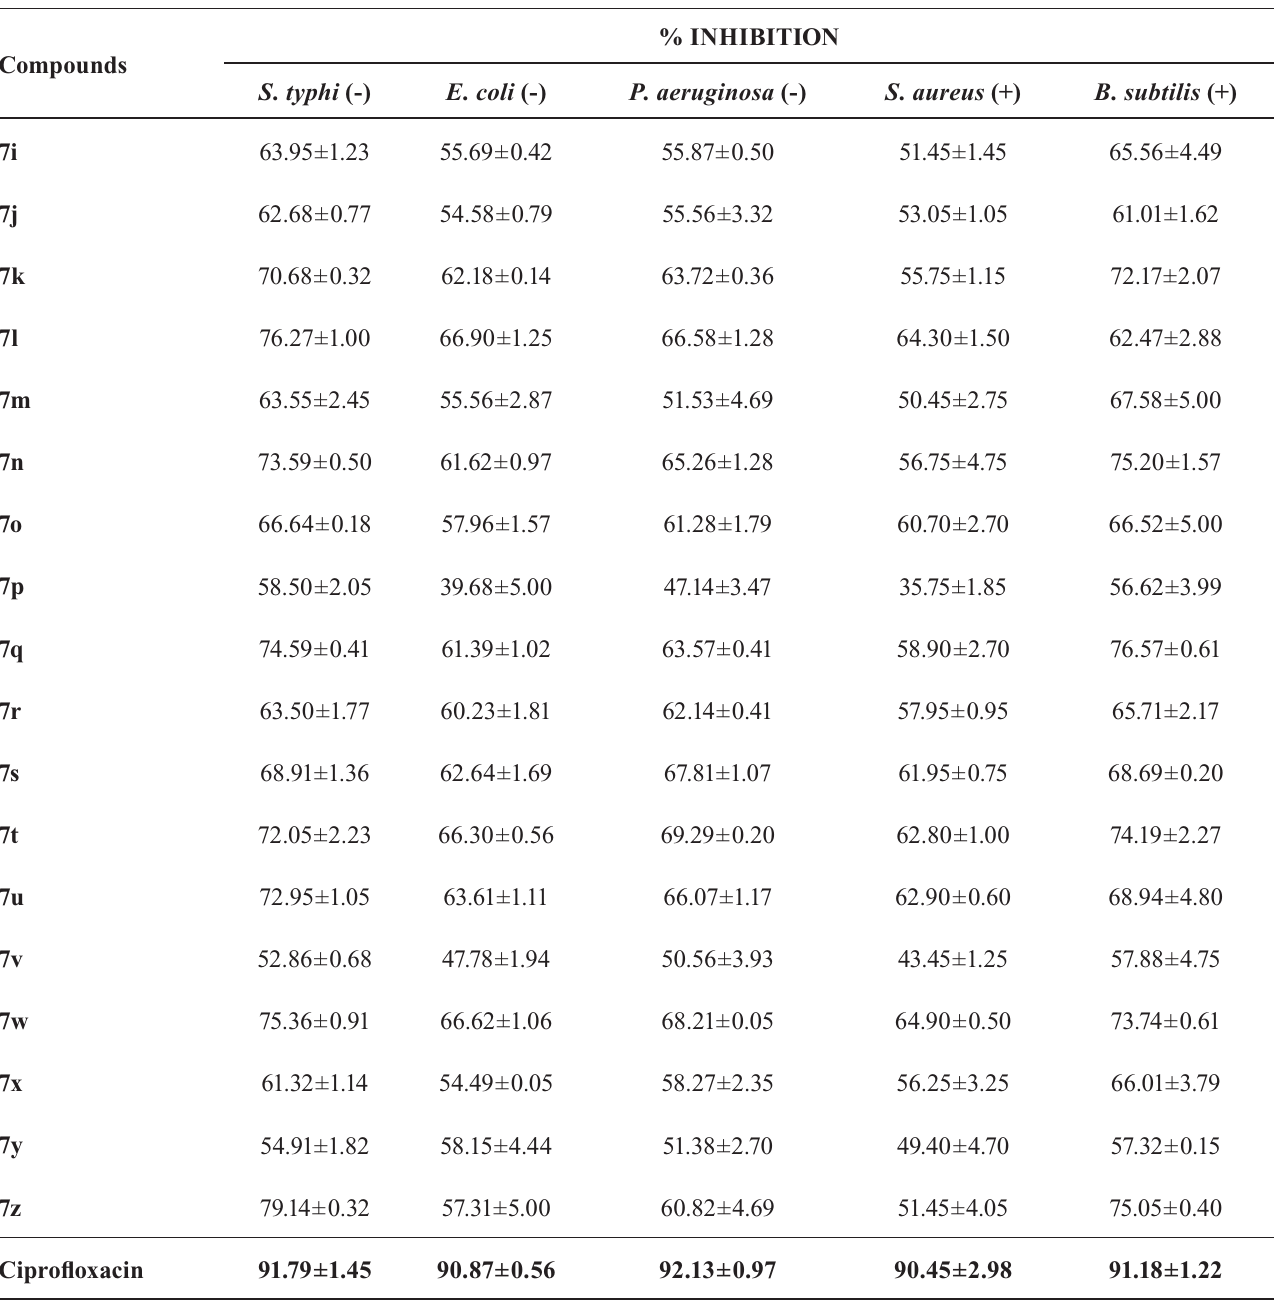
TABLE II - The % inhibition for antibacterial activity of synthesized compounds